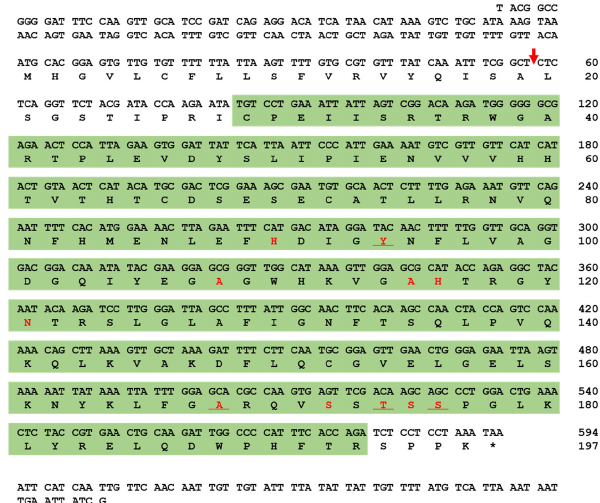
Figure 1. Nucleotide and deduced amino acid sequence of T. molitor peptidoglycan recognition protein-SA ( Tm PGRP-SA). The nucleotide and amino acid sequence numbers are shown at the right margin, indicating that full-length open reading frame (ORF) sequence of Tm PGRP-SA consists of 594 nucleotides encoding 197 amino acid residues. The predicted signal peptide cleavage site is marked with a red arrow. The amidase/PGRP domain predicted by InterProScan 5.0 is highlighted in the green box. The amidase catalytic site (active site) is underlined and chemical (substrate) binding site is shown in red.